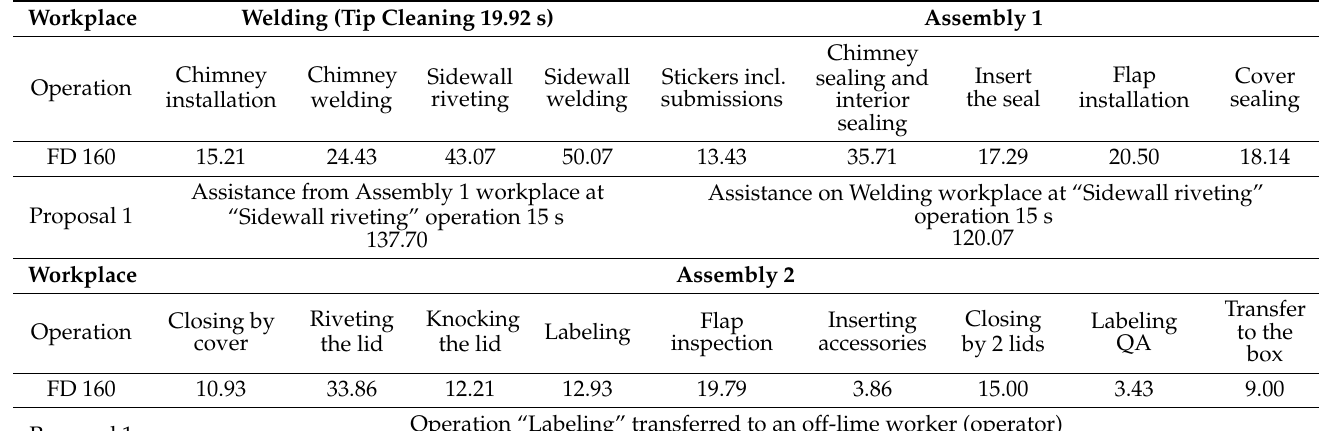
Table 6. Proposal 1—time consumption (in seconds) according to assembly operations and line workplaces.